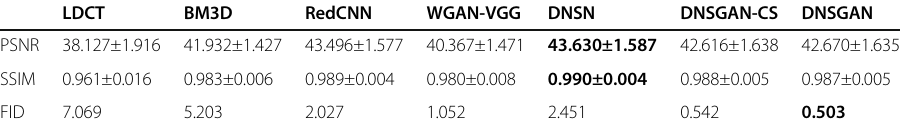
Table 3 The qualitative results of compared methods in the TestSet